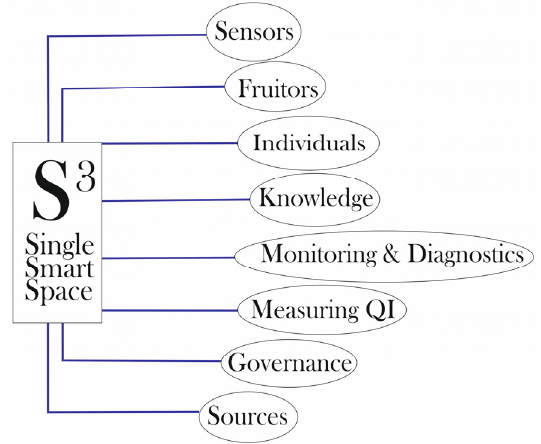
Figure 5. The single smart space S 3 model.